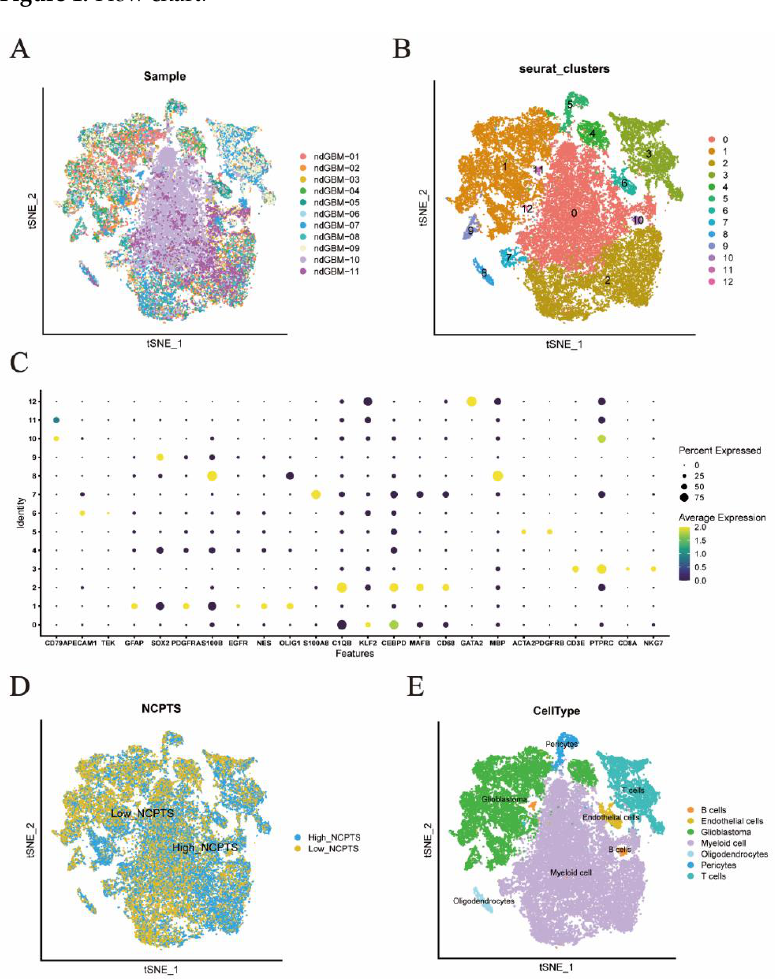
Figure 2. Single-cell sequencing analysis of GSE182109. ( A ) The integration effect of 11 samples is good. ( B , C ) Dimensionality reduction and cluster analysis. All cells in 11 samples were clustered into 12 clusters. ( D ) The percentage of necroptosis genes in each cell. The cells were divided into high- and low-necroptosis cells. ( E ) According to the surface marker genes of different cell types, the cells are annotated as B cells, T cells, endothelial cells, myeloid cells, pericytes, oligodendrocytes, and glioblastoma cells,